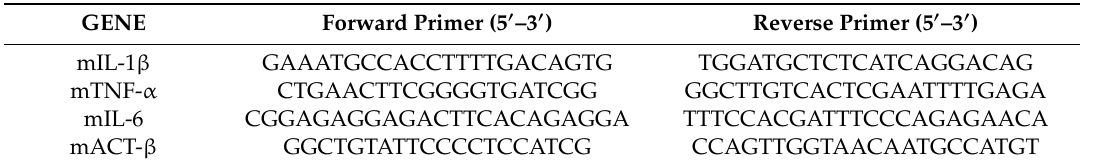
Table 1. Primers used.